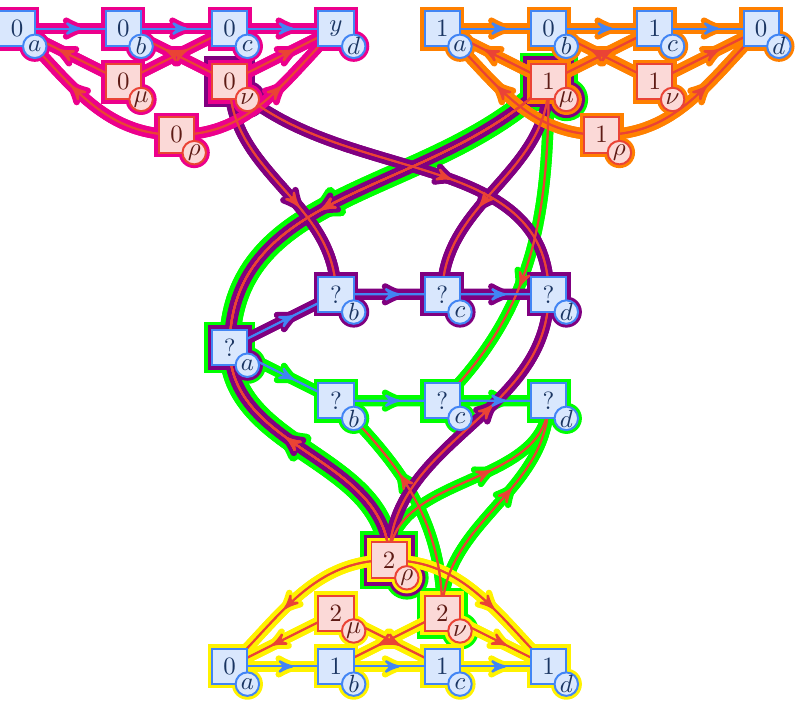
Figure 14: A possible worlds diagram for G 13 initialized by the distribution in Equation 38. The worlds are colored: wor (0 µ 0 ν 0 ρ ) magenta, wor (1 µ 1 ν 1 ρ ) orange, wor (2 µ 2 ν 2 ρ ) yellow, wor (1 µ 0 ν 2 ρ ) violet, and wor (1 µ 0 2 ν 2 ρ )